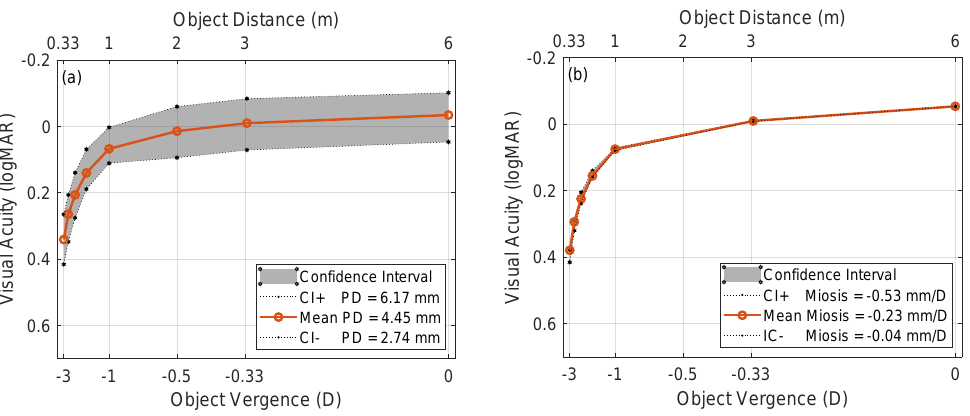
Figure 5. Predicted visual acuity in logMAR (MAR: Minimum Angle of resolution) variation as function of object vergence in diopters, using the simulated area under MTF curve and Equation (10), from near ( OV = − 3 D) to far ( OV = 0 D) object distances: ( a ) Case 1 models with constant pupil miosis and varying distance pupil diameter (PD) values; and ( b ) Case 2 models with constant distance pupil and varying pupil